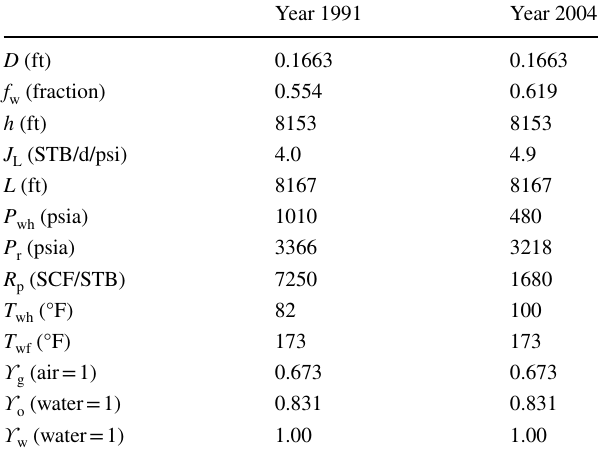
Table 4 Relevant data of well V2‑B